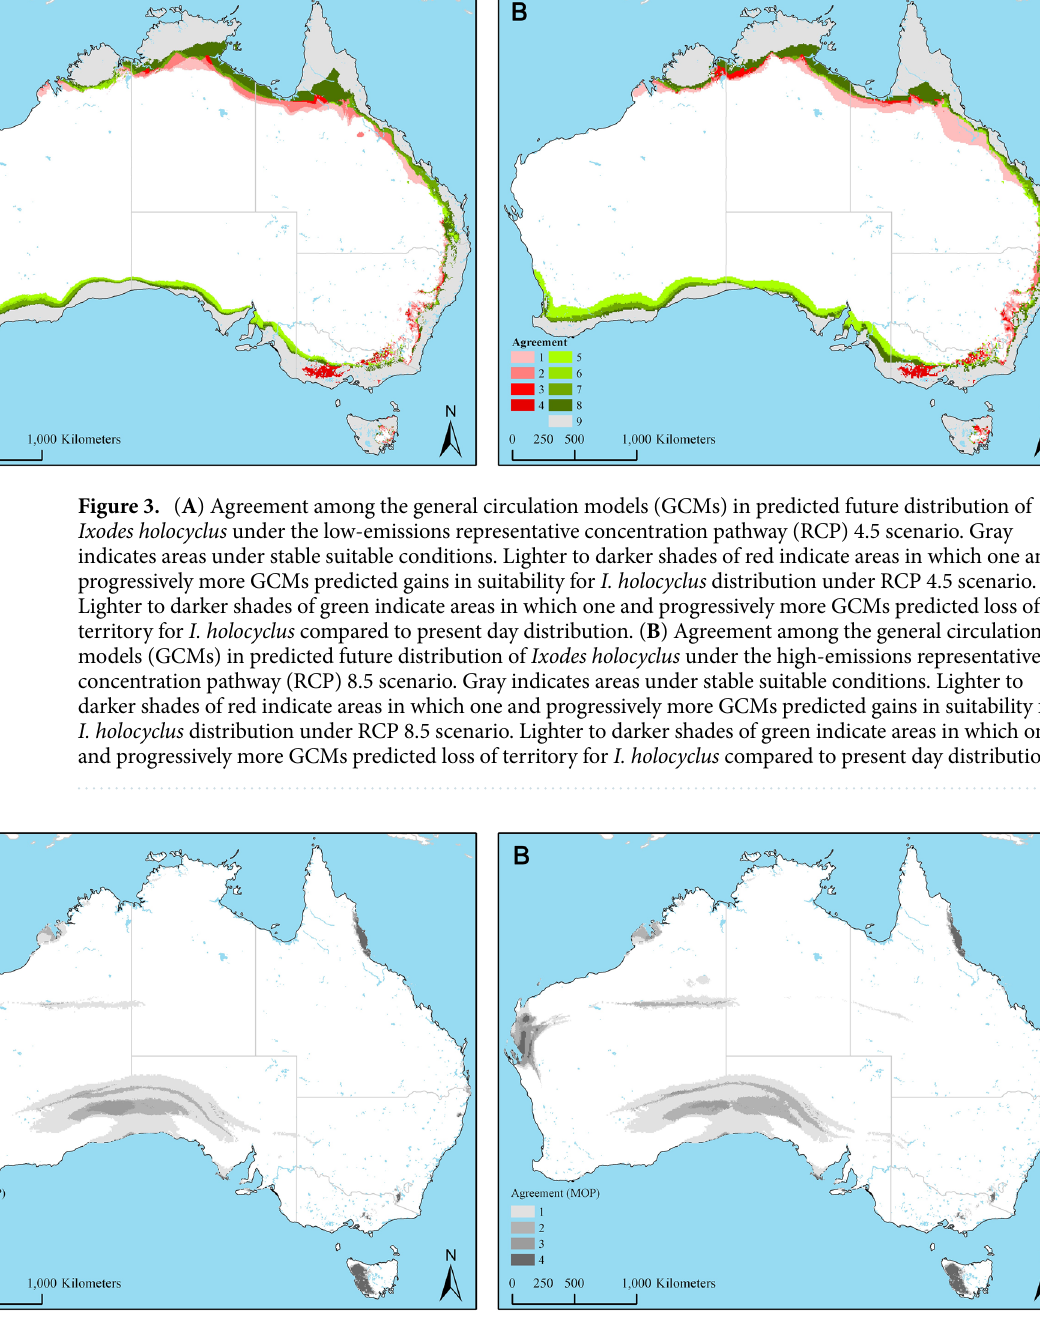
Figure 4. ( A ) Agreement among the four general circulation models (GCMs) in strictly extrapolative areas under future climate change low-emissions scenario (RCP 4.5). Lighter to darker shades of gray indicate the increasing level of agreement of strictly extrapolative areas for I. holocyclus derived from the GCMs. ( B ) Agreement among the four general circulation models (GCMs) in strictly extrapolative areas under future climate change high-emissions scenario (RCP 8.5). Lighter to darker shades of gray indicate the increasing level of agreement of strictly extrapolative areas for I. holocyclus derived from the